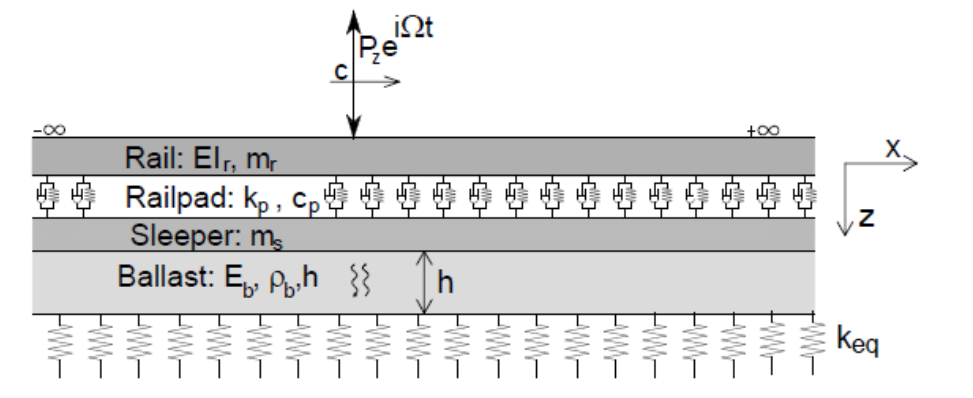
Table 1. Mechanical properties of the track model [26].